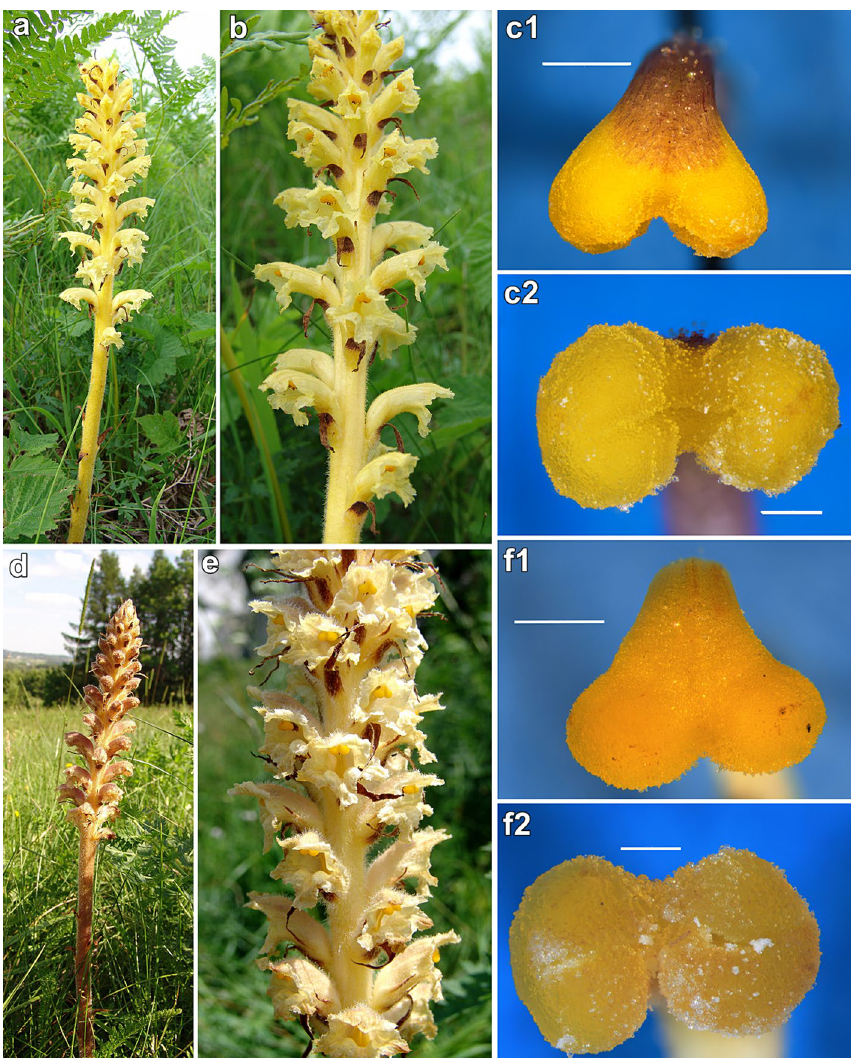
Figure 5. Studied holoparasitic Orobanche alsatica ( a , b , c ) and O. bartlingii ( d , e , f ): ( a , d ) general habit; ( b , e ) closed and opened flowers, phot. R. Piwowarczyk; ( c , f ) ZOOM micrographs of two-lobed mature stigmas of O. alsatica and O. bartlingii with numerous papillae covered with a viscous secretion. Scale bars: ( c1 , f1 ) 1000 µm; ( c2 , f2 ) 500 µm. Phot. K.